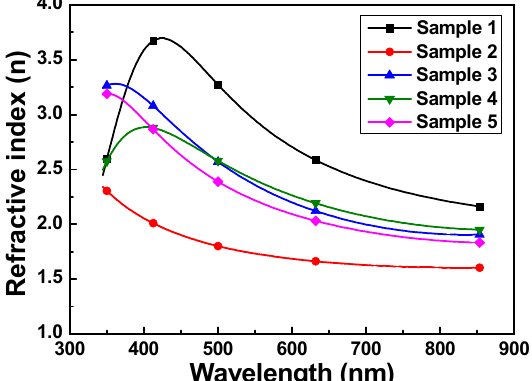
thin films as a function of deposition x